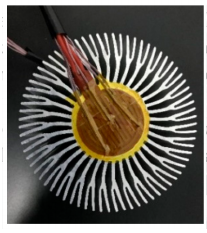
Figure 3. Heating film on the heat sink. Table 2. Some working parameters of the heating film in this work.